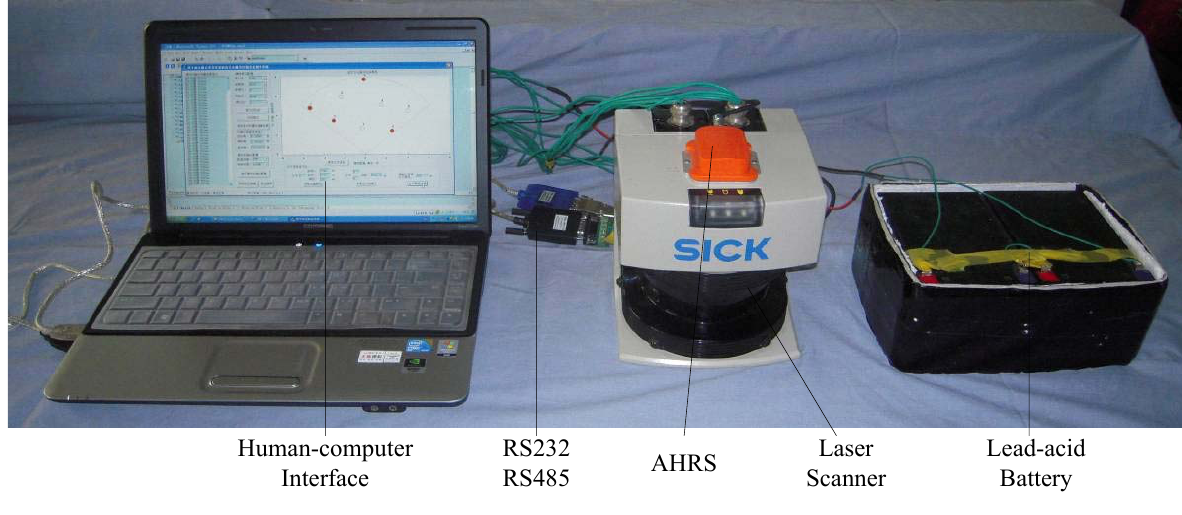
Figure 1. The whole hardware of measurement